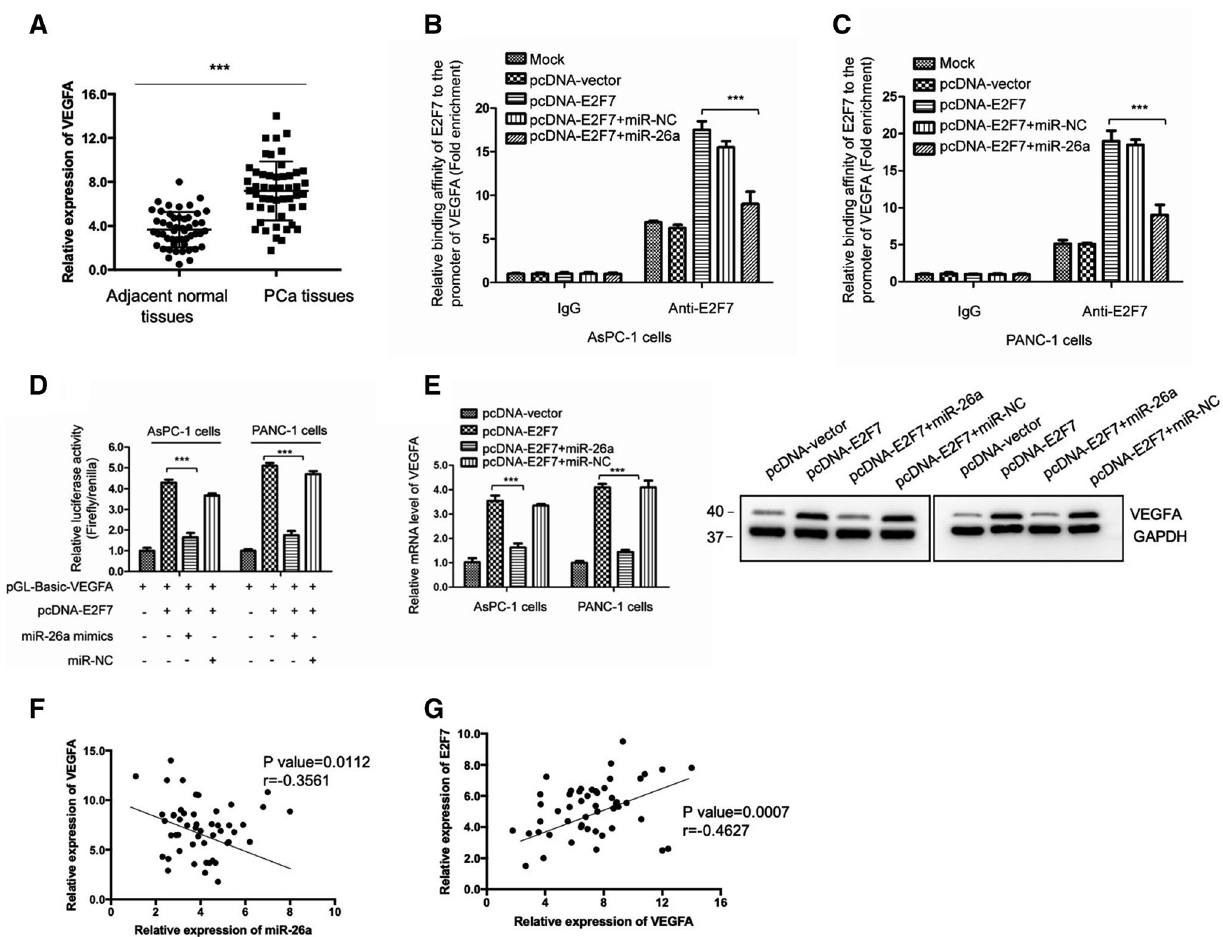
Fig. 5 miR-26a negatively regulated E2F7-mediated transcriptional activation of VEGFA. A mRNA levels of VEGFA were overexpressed in PCa tissues. B , C The binding between E2F7 with the VEGFA promoter under different conditions was detected by CHIP. D The binding of E2F7 with the VEGFA promoter region was examined by luciferase reporter analysis. E The mRNA levels of VEGFA under the indicated conditions were compared via RT-qPCR. F , G The correlation between the expression of VEGFA with miR-26a or E2F7 in PCa tissues. *** P <